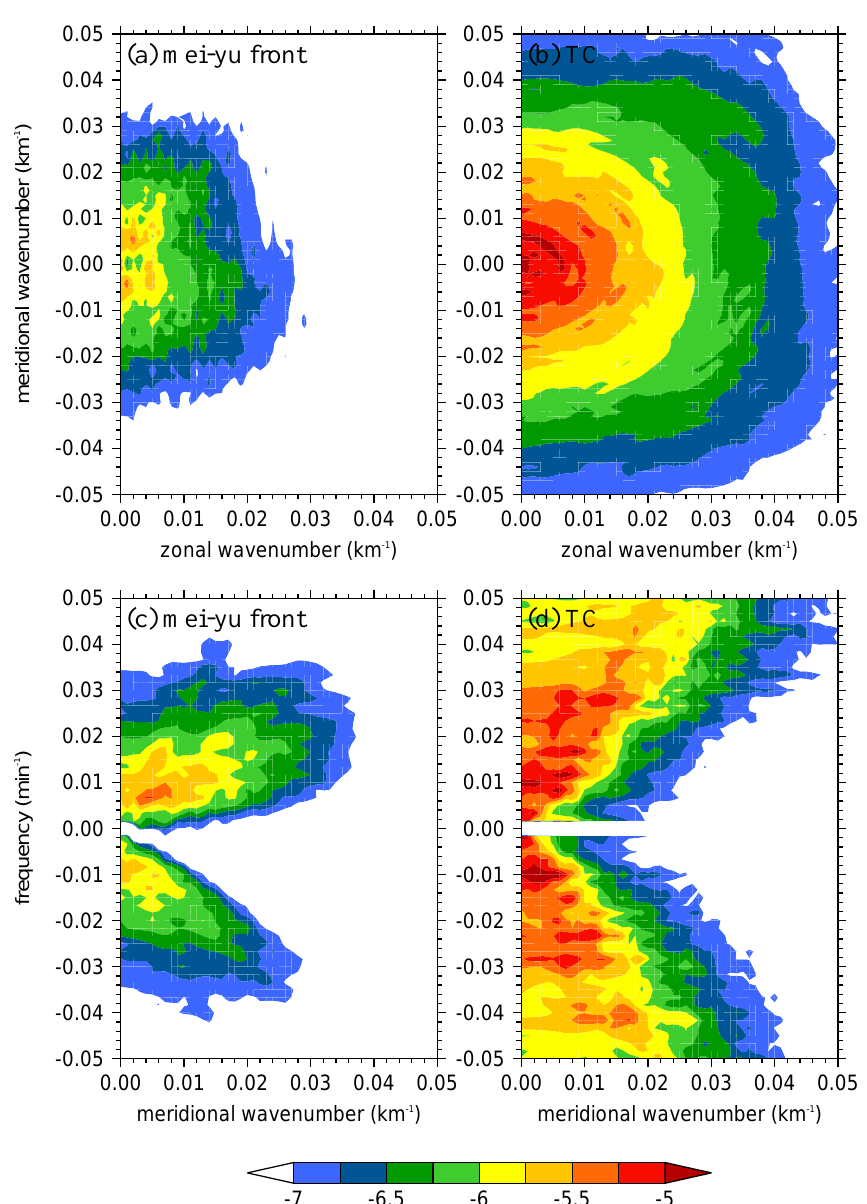
Figure 4. Base-10 logarithm of PSDs of w GW (shaded; m 2 s –2 ) as a function of ( a , b ) zonal and meridional wavenumber, and ( c , d ) meridional wavenumber and frequency at z = 17 km, for ( a , c ) the mei-yu front and ( b , d ) the TC.